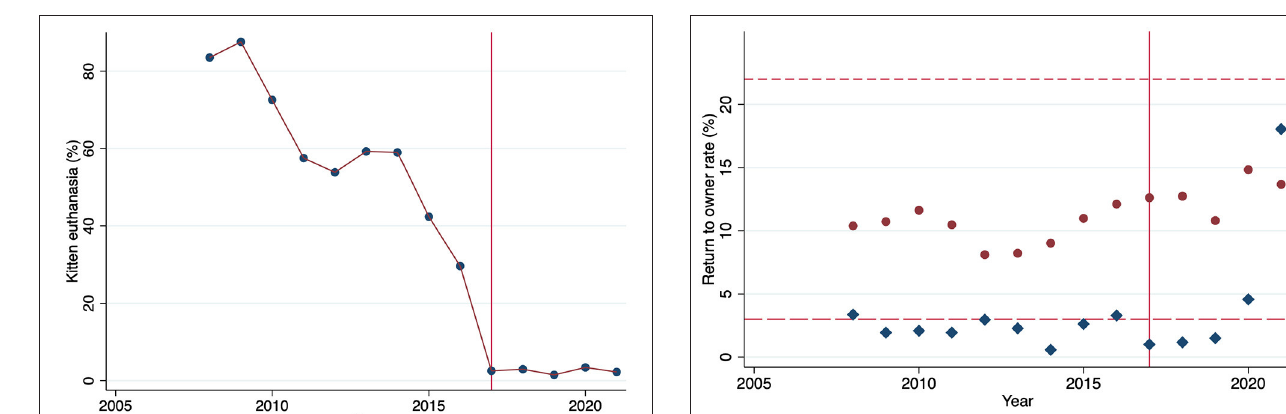
0.565) or dogs ( P = 0.460).